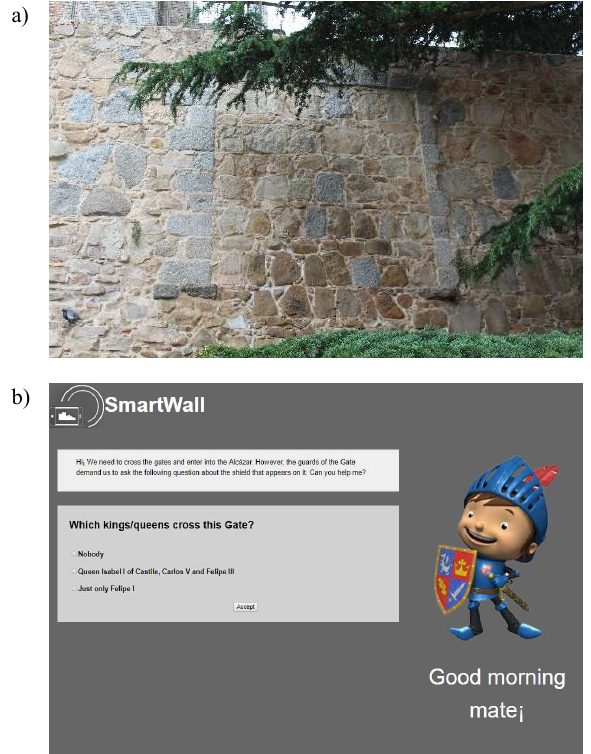
Figure 2. An example of the different areas of interest for a non-